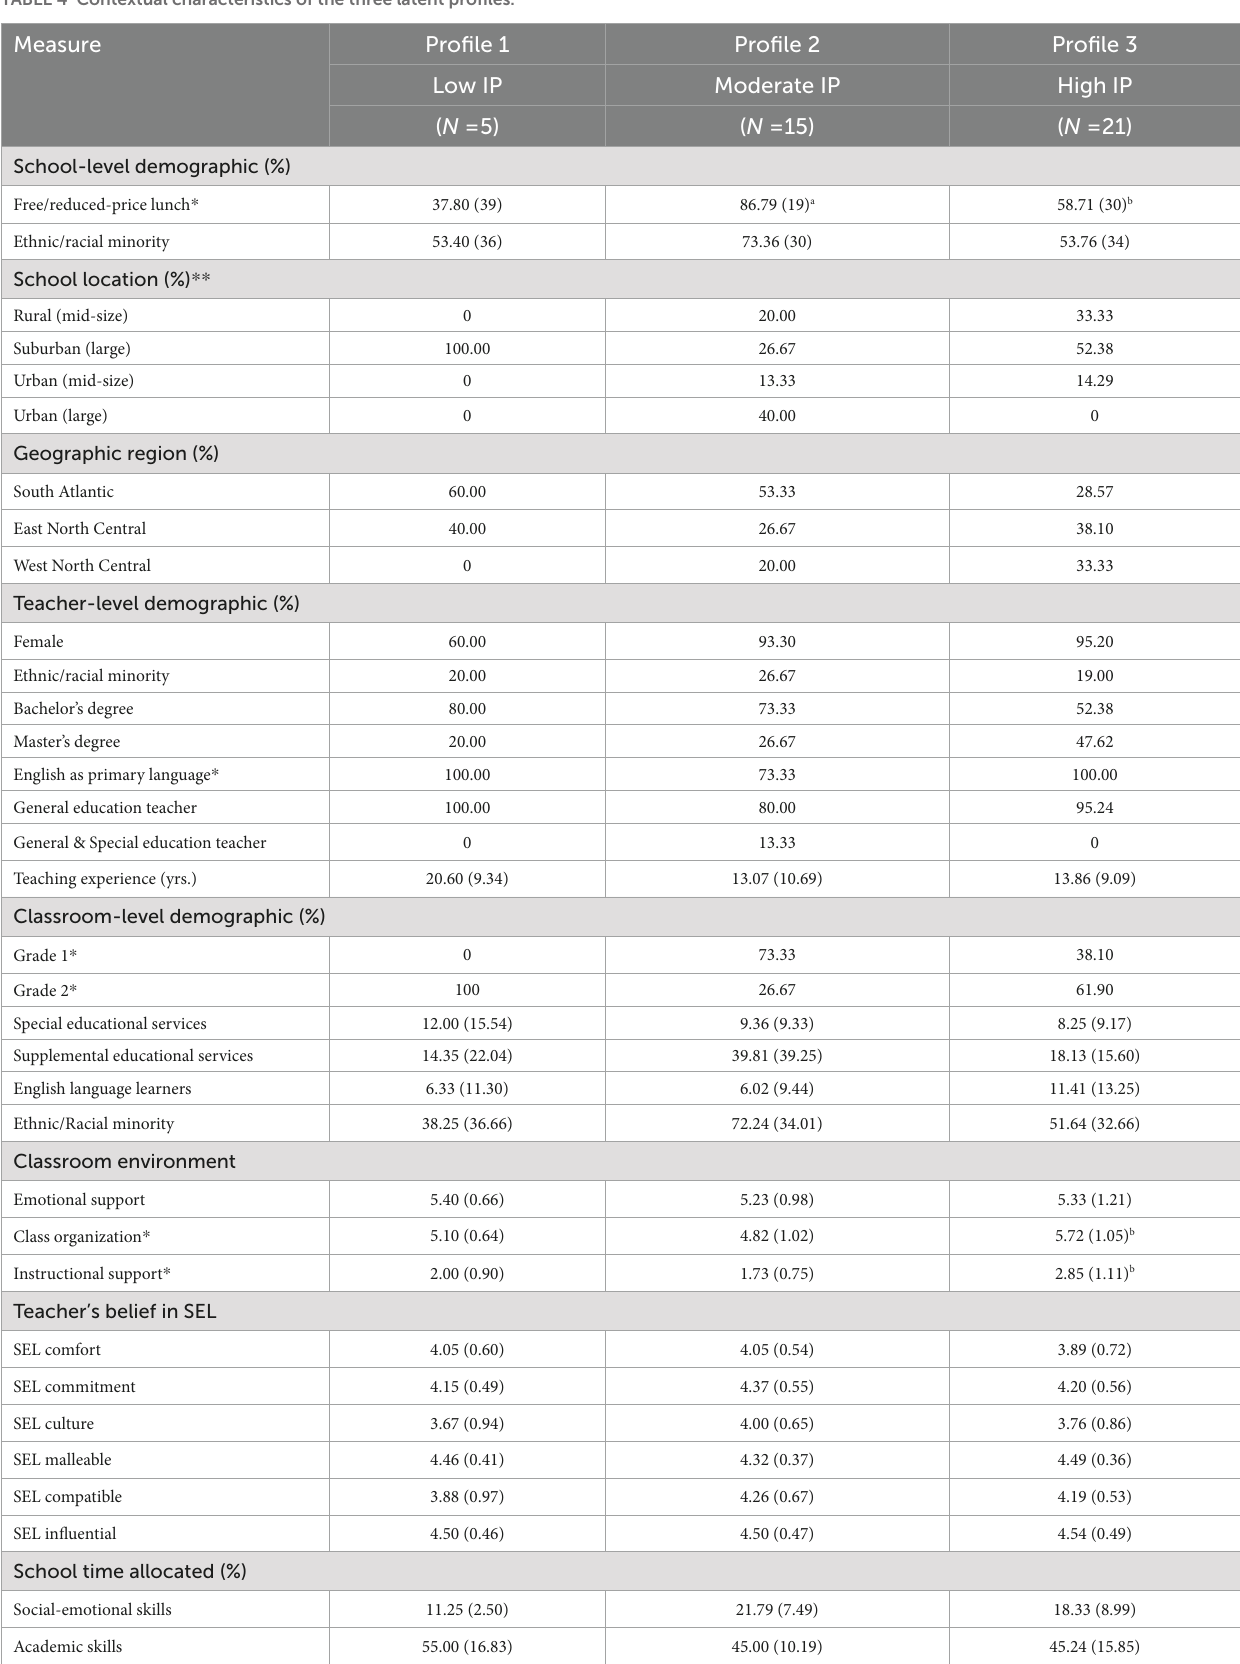
TABLE 4 Contextual characteristics of the three latent